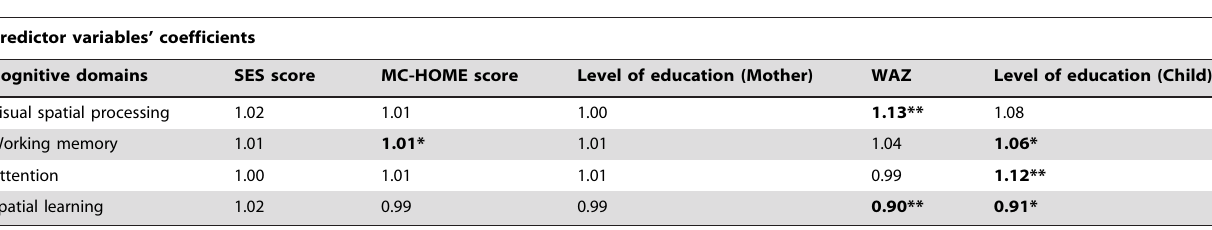
Table 4. Exponentiated coefficients represent percent change in the geometric mean per unit of the predictor variable 1 .